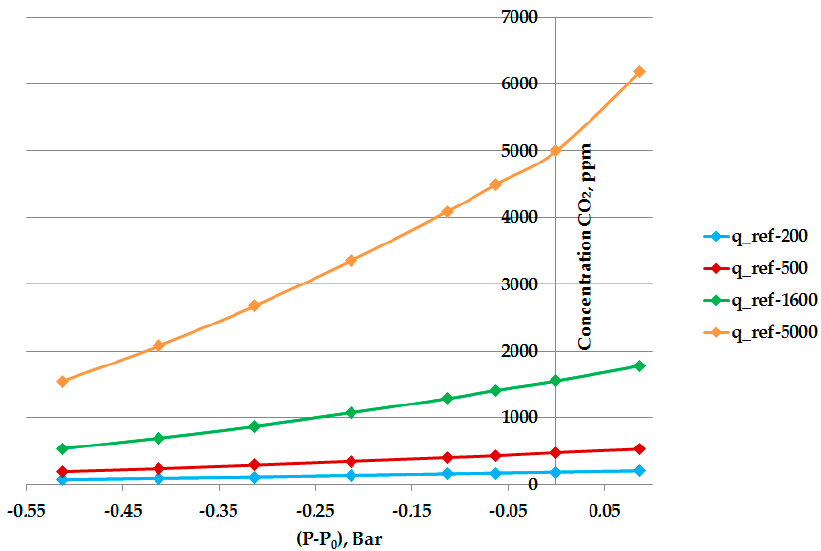
Figure 7. The pressure calibration data for reference concentrations 200, 500, 1600, and 5000 ppm CO 2 .